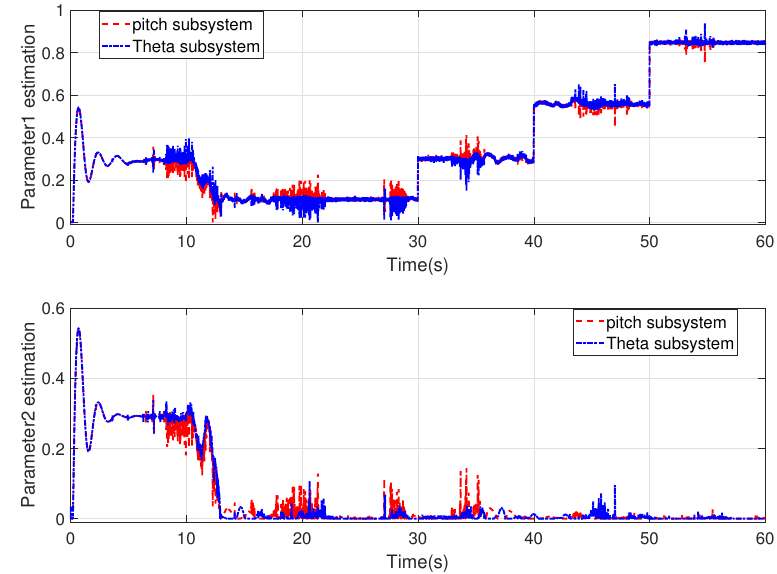
Figure 14. Estimation of parameters 1 and